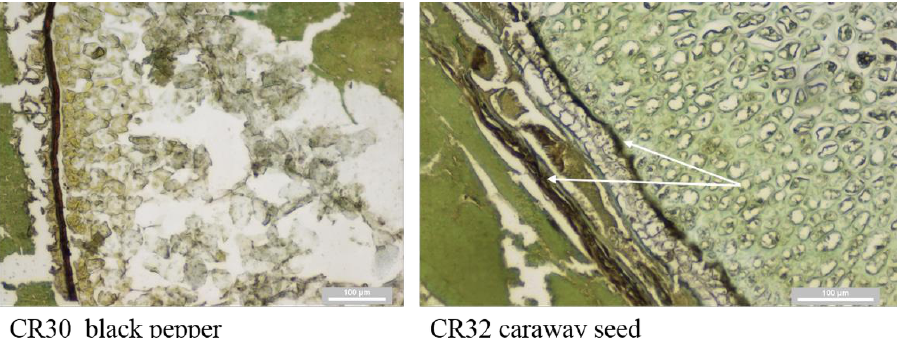
Figure 3. Structure of black pepper (CR30) and caraway (CR32) by lectin histochemistry; natural brown pigmentation.